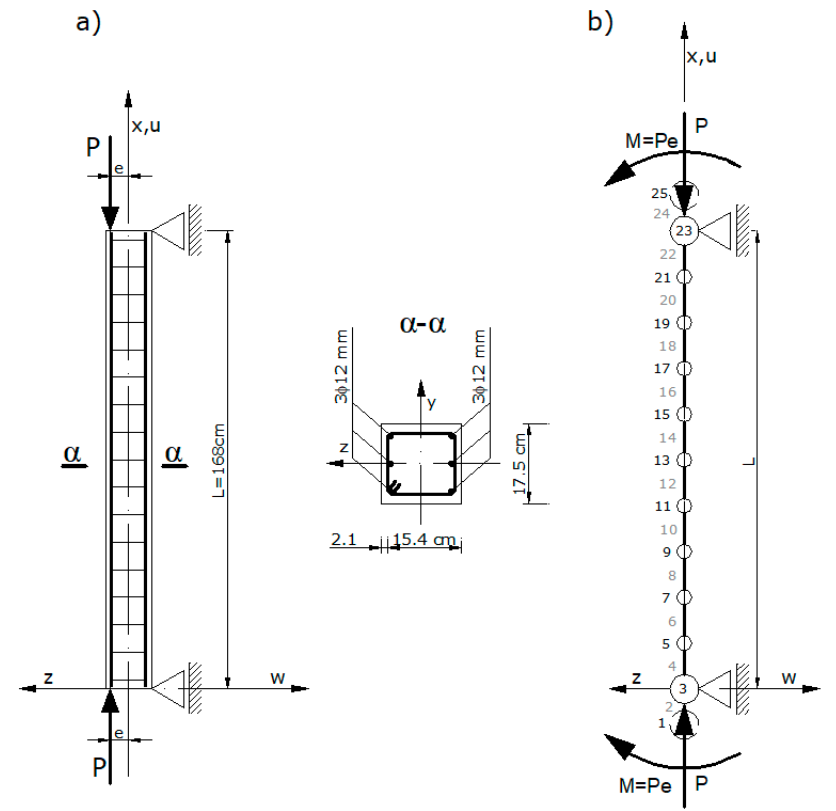
Figure 11. The IB column, as presented in the paper [29]: ( a ) static scheme; ( b ) computational model of the column.